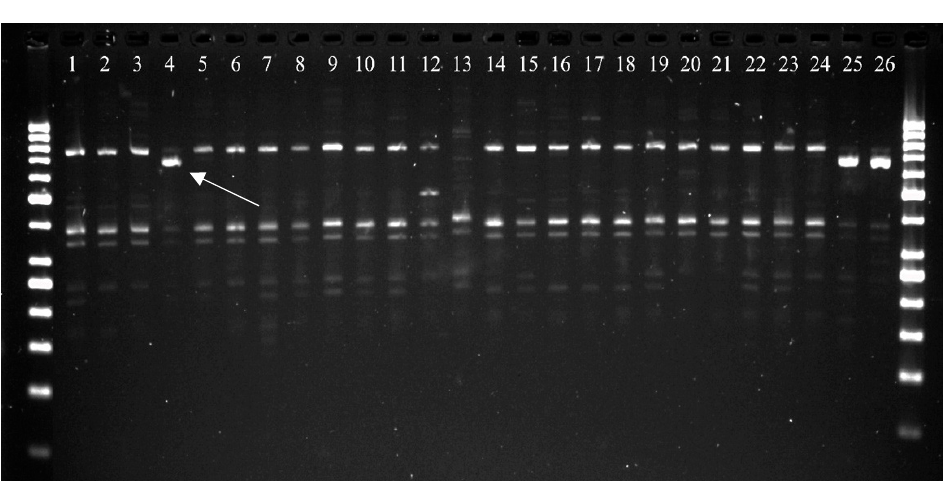
Figure 1. PCR products for NL9F5 marker linked to Sr35 stem rust resistance gene. 1–24— T. monococcum genotypes (Table 1). 25 and 26—positive controls (GSTR 526 and PI 428170). An arrow indicates a 719 bp product linked to resistance allele.